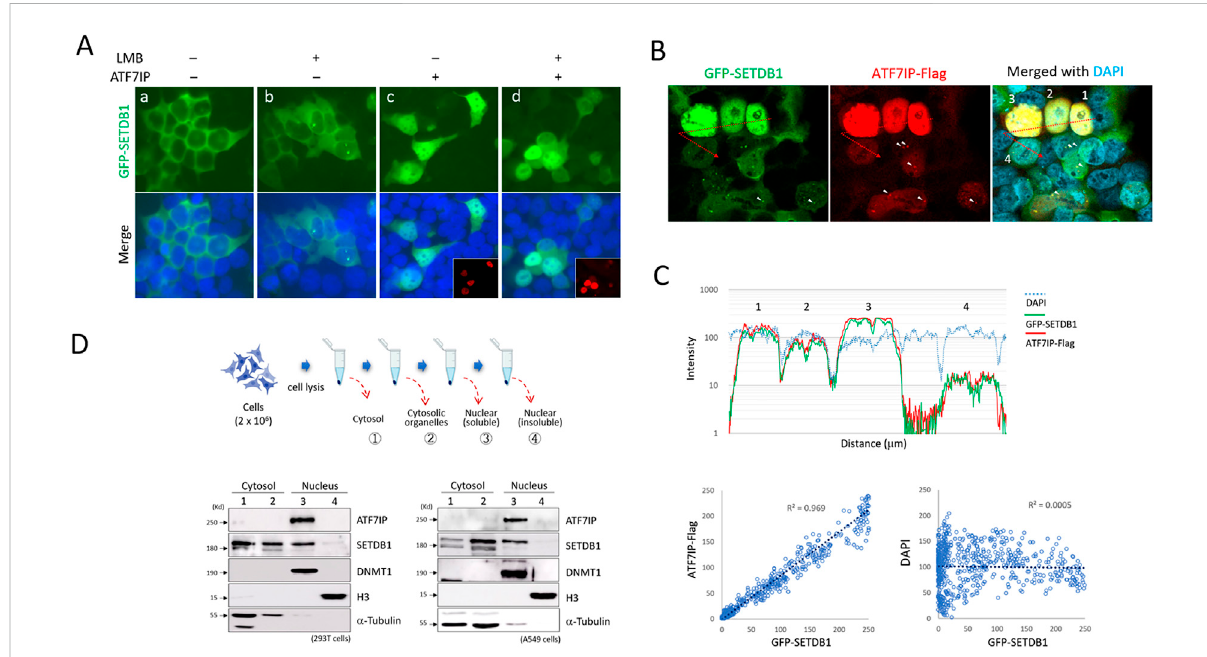
FIGURE 2 Induction of cytoplasmic GFP-SETDB1 into the nucleus by ATF7IP (A) Nuclear localization of GFP-SETDB1 after ATF7IP-Flag overexpression. ATF7IP overexpression stimulates GFP-SETDB1 to enter the nucleus, regardless of leptomycin B (LMB) treatment. The insets in (c and d) indicate ATF7IP-Flag IF images. (B – C) Correlation between ATF7IP-Flag and nuclear GFP-SETDB1 expression levels. In (C) , a signal intensity pro fi le (top) and scatter plots (bottom) were produced from the merged picture in (B) using ‘ Pro fi le ” tool offered in the Zen program (v3.4) from Carl Zeiss microscopy. It reveals that the density of nuclear GFP-SETDB1 signal closely correlates with that of ATF7IP-Flag signal. Scatter plots were created using fl uorescence intensity values per micrometer of distance. The cells in (B and C) are identically numbered for analysis (1 – 4). The colocalization of the dotted GFP-SETDB1 and ATF7IP-Flag signals is shown in (B) by the arrowheads. (D) Western blotting results after subcellular fractionation in 293T (bottom, left) and A549 cells (bottom, right). Fraction procedure is illustrated (top) in the order of cytosolic (1), cytosolic organelle (2), nucleoplasmic (3), and insoluble chromatin fractions (4). DNMT1, a nuclear marker; H3, an insoluble chromatin marker; α -tubulin, cytosolic